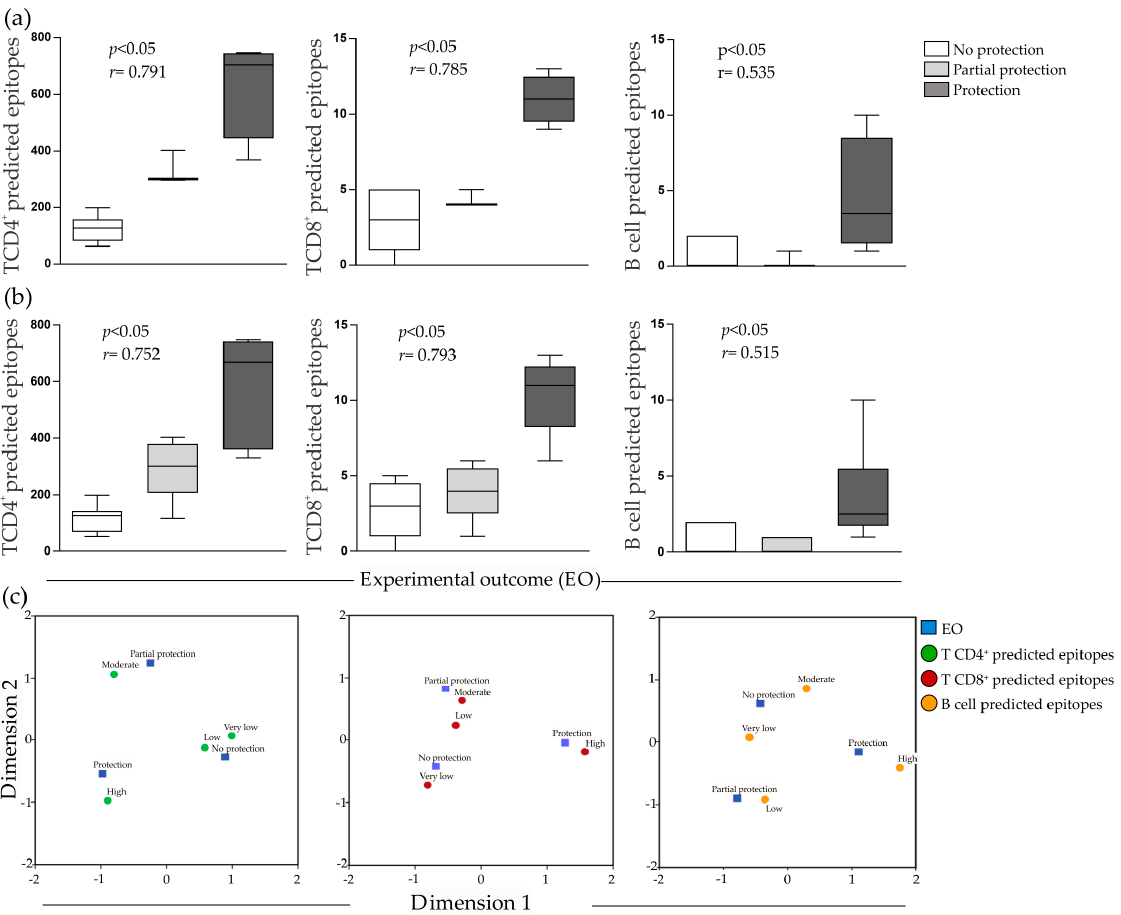
Figure 1. Correlation analysis: ( a ) Box plots of the relationships between T CD4 + , T CD8 + and B cell epitopes and experimental outcome of candidate antigens taking into account cutaneous leishmaniasis (CL); ( b ) box plots of the relationships between T CD4 + , T CD8 + and B cell epitopes and experimental outcome of candidate antigens concerning leishmaniasis diseases with no stratification; and ( c ) correspondence map showing the association between experimental outcome and T CD4 + , T CD8 + and B cell predicted epitopes for leishmaniasis with no stratification.